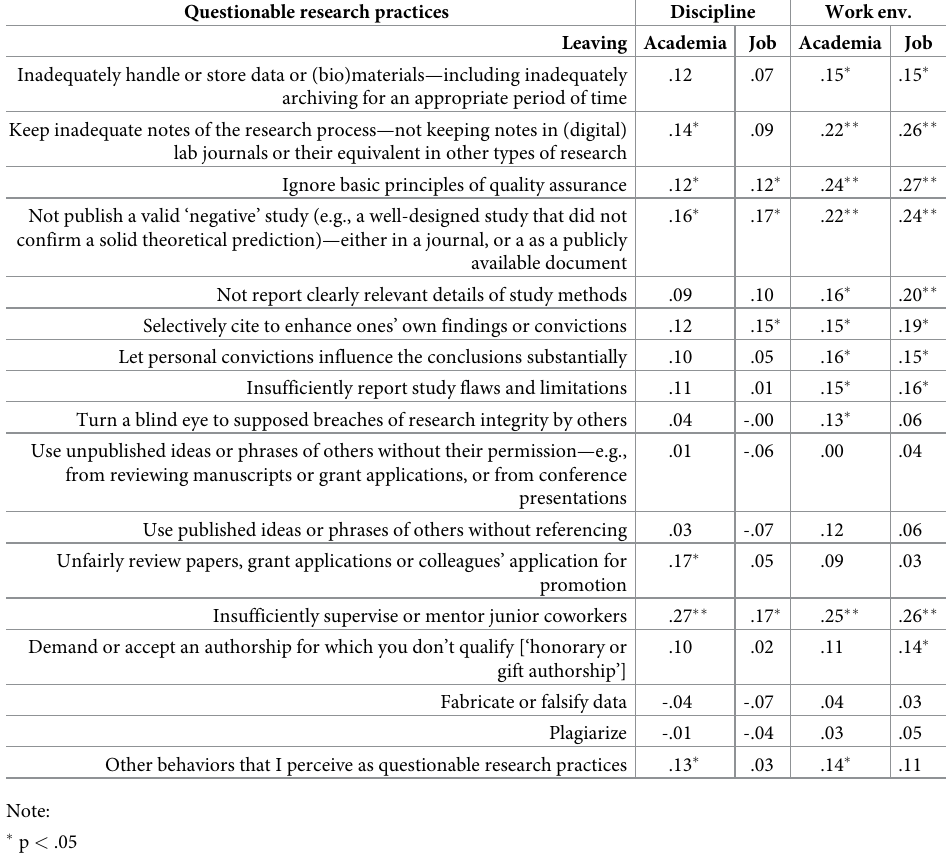
Table 8. Correlations between perceived prevalence of questionable research practices within the discipline and work environment, and considerations about leaving academia or